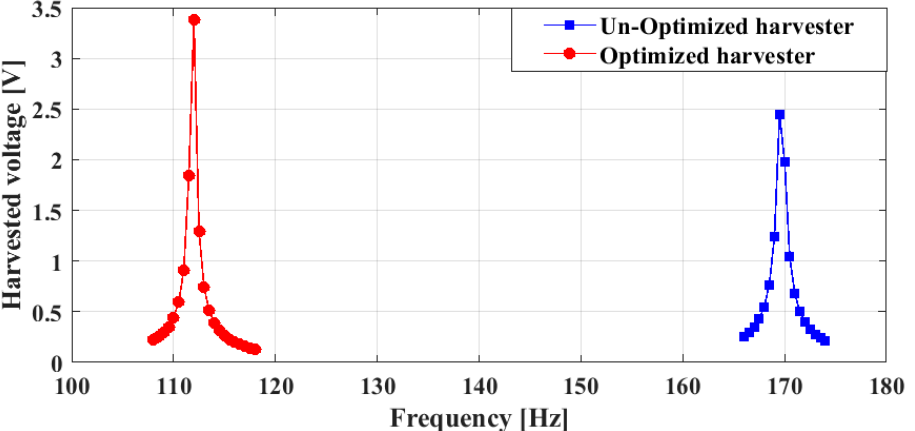
Figure 3. Frequency spectra of the un-optimized and optimized low-resonant-frequency piezoelectric MEMS energy